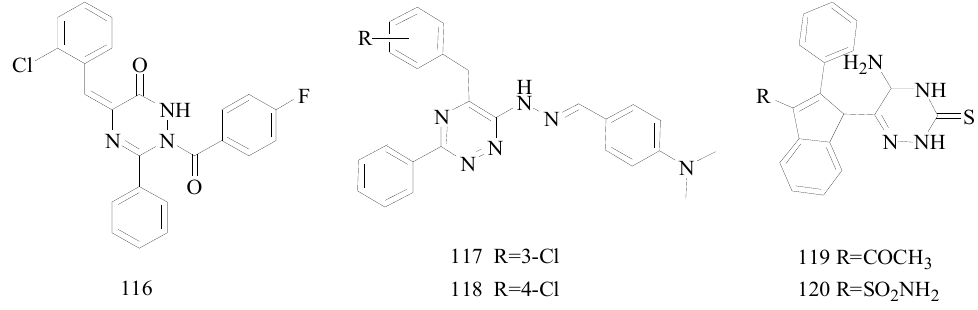
Figure 9. Structures of compounds 116 – 120 .